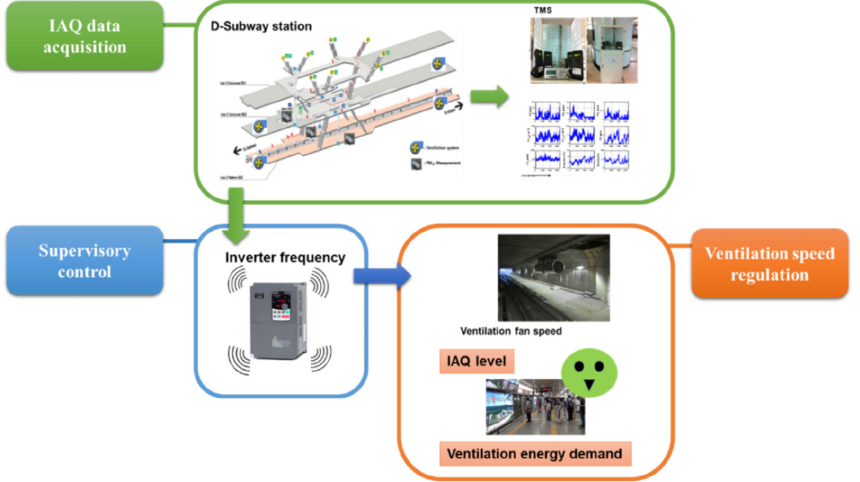
Figure 10. Diagram of the air quality monitoring and supervisory control process. Reproduced with permission from IEEE